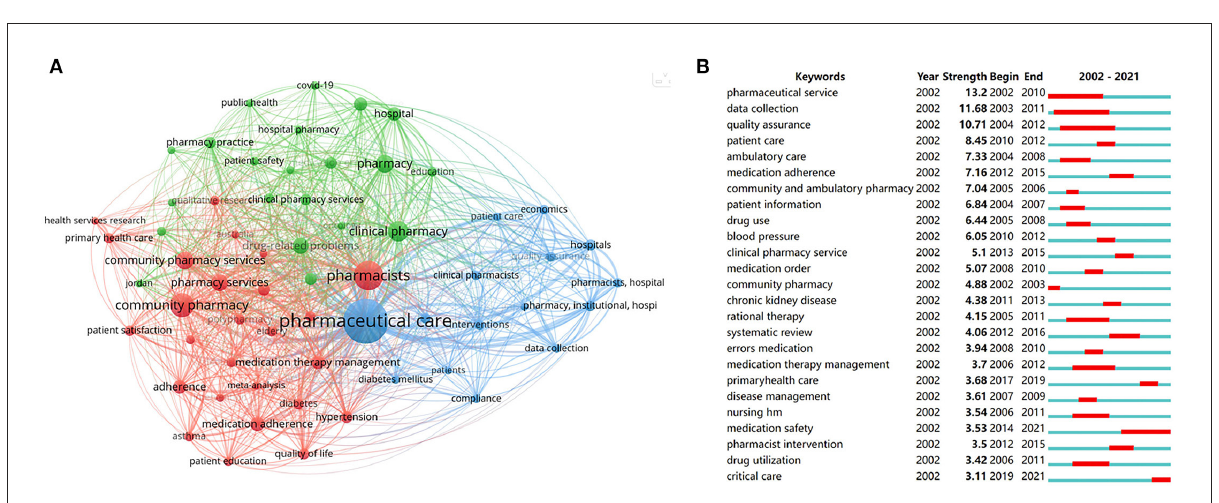
FIGURE8 Analysis of keywords. (A) Co-occurrence analysis of keywords with the threshold over 30. (B) Burst analysis of the top 25